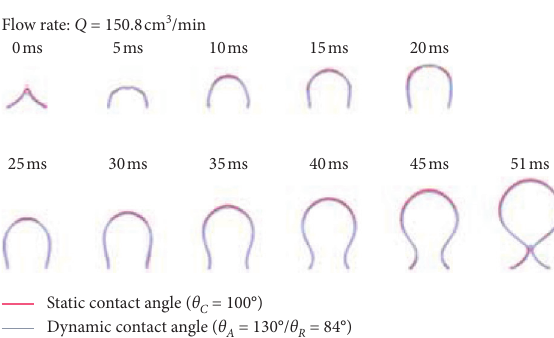
Figure 5: Comparison of profile between dynamic and static contact angles ( Q � 150.8 cm 3 /min, Re � 54.77, and d contact angle period: 0–25 ms; receding contact angle period: